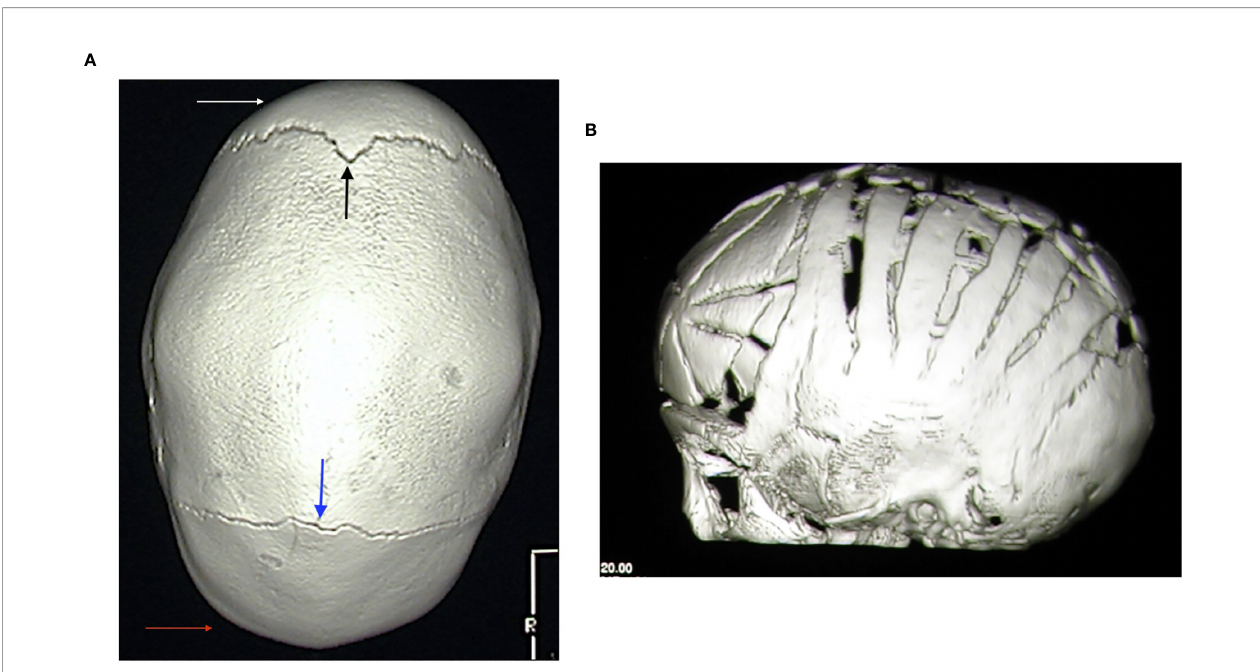
FIGURE 4 | (A) 3D-reformatted axial computed tomography scan showing fusion of the sagittal suture and classic scaphocephalic head shape in a 3.2-year-old male patient with XLH. Frontal (white arrow) and occipital (red arrow) bossing with open coronal (black arrow) and lambdoid (blue arrow) sutures is also evident. (B) 3D-reformatted axial computed tomography scan showing the neurosurgical correction of scaphocephaly in a 8-month-old male patient with